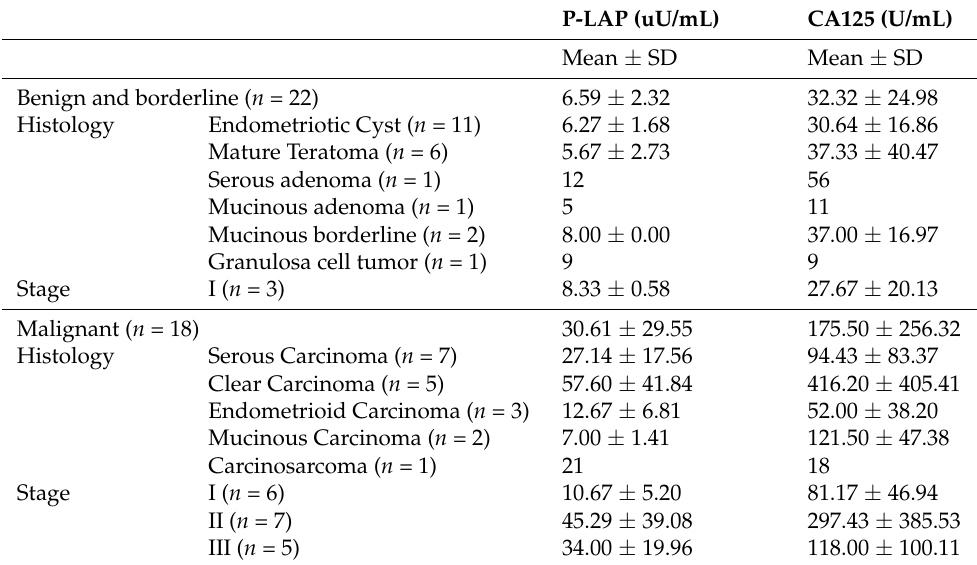
Table 1. Urinary P-LAP levels and serum CA125 levels in ovarian tumor patients by histological types and stages.